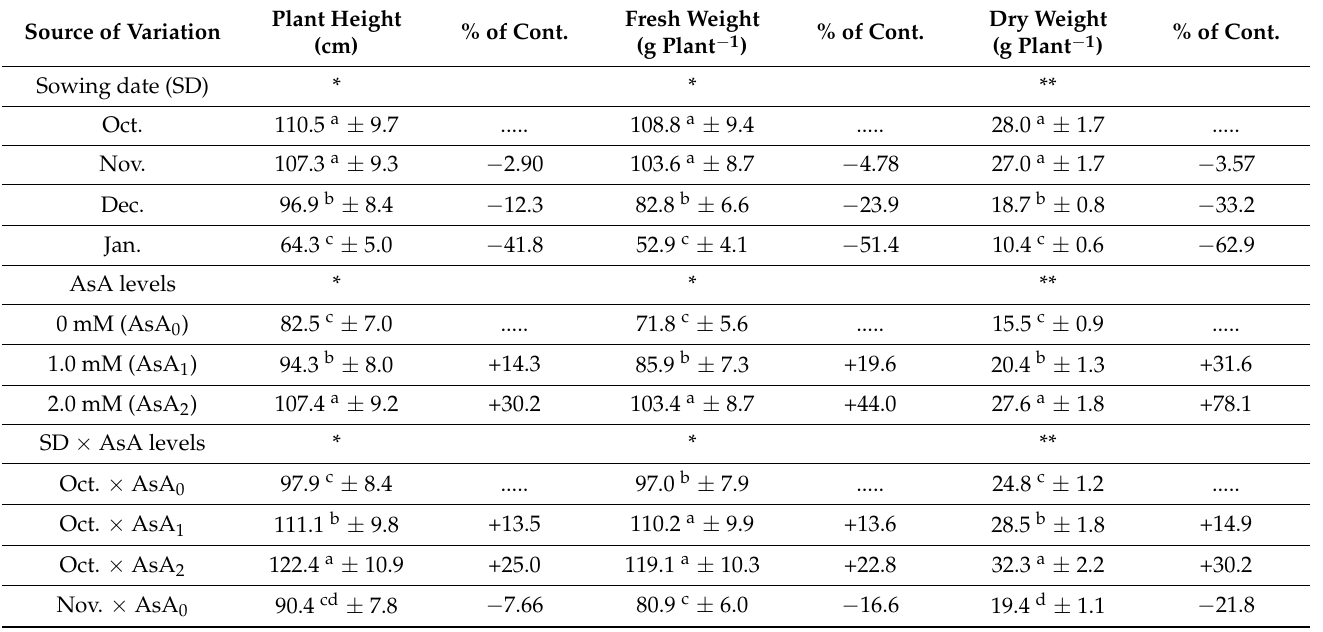
Table 1. Effect of integrative treatment of seeds and leaves with ascorbic acid (AsA) on growth traits of parsley plants under different sowing dates vs. October. All values are the average of